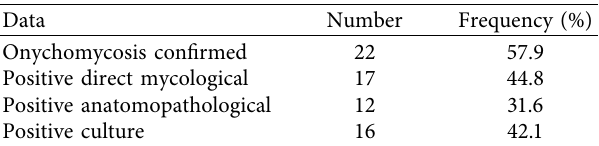
Table 2: Frequency of onychomycosis and laboratory results of nail analysis of psoriatic patients.